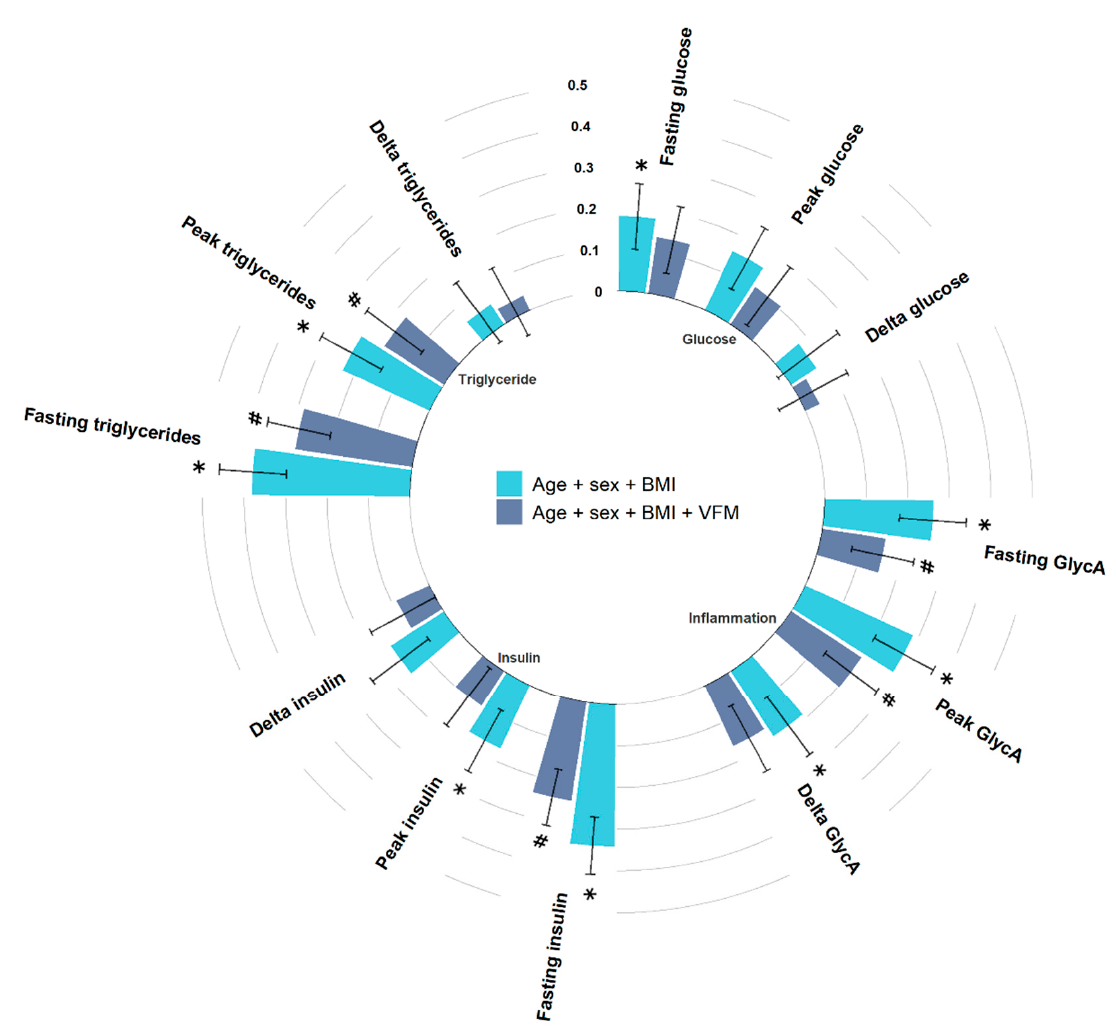
Figure 2. Circos bar plot with bars representing standardised coefficients of linear models between metrics and hypertension status with error bars representing standard error. Bars are colour coded based on covariates. Light blue bars indicate adjustment for age, sex, and BMI, while navy bars indicated adjustment for age, sex, BMI, and VFM. * FDR < 0.05 (for age, sex, and BMI adjusted model), # nominal significant (for age, sex, BMI, and VFM adjusted model). Abbreviations: BMI, body mass index; VFM, visceral fat mass.